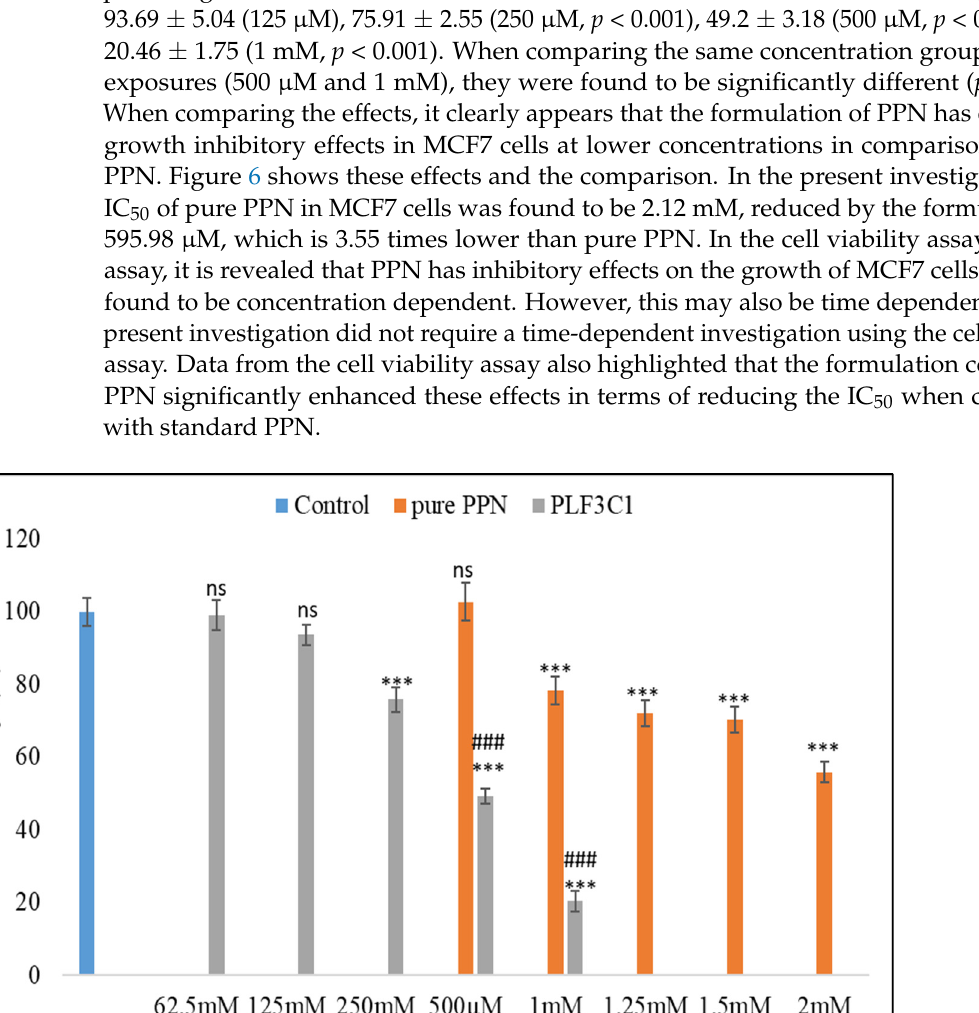
Figure 5. Antioxidant activity of the tested samples using the DPPH method. The Tukey–Kramer multiple comparison test was utilized to analyze the statistically significant difference between each group. Difference was considered significant if p < 0.05. ns = not significant when compared between PPN liposomes (PLF3) and chitosan-coated PPN liposomes (PLF3C1); *** = p < 0.001 when compared with pure PPN; ** = p < 0.01 when compared with pure PPN.